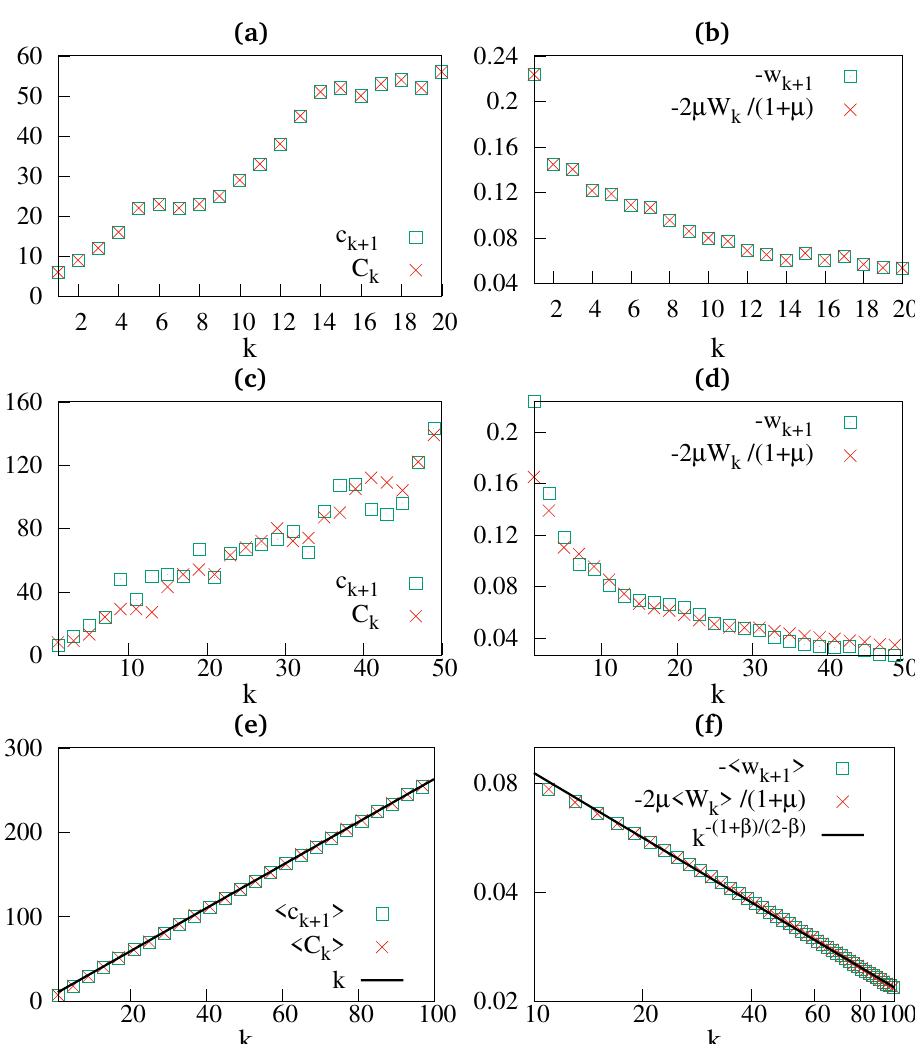
Figure 6: (a,b) Verification of Eqs. (35c) from microscopic simulations. We computed the number of collisions experienced and the frozen velocities of different splatter particles after a sufficiently long time ( t = 6.4 × 10 5 ). In all cases we checked that increasing time by a factor of 10 did not lead to any more collisions for these particles.